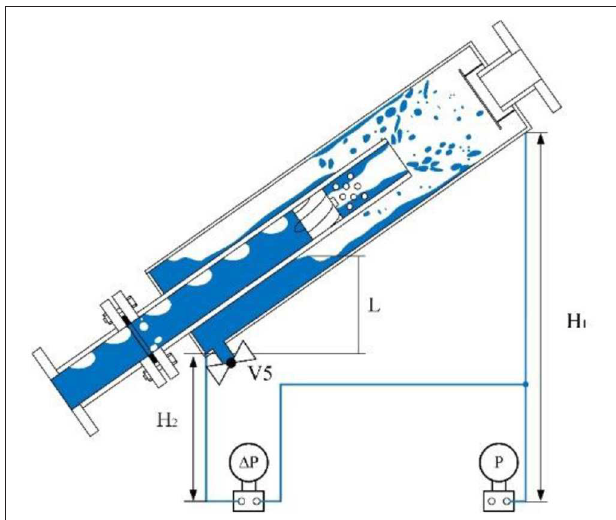
By comparing the liquid level with the scale of the scale in the photograph, the accurate liquid level value can be obtained. In each working condition, in order to ensure the accuracy of the liquid level measurement results, these two liquid level measurement methods were averaged by multiple measurements.